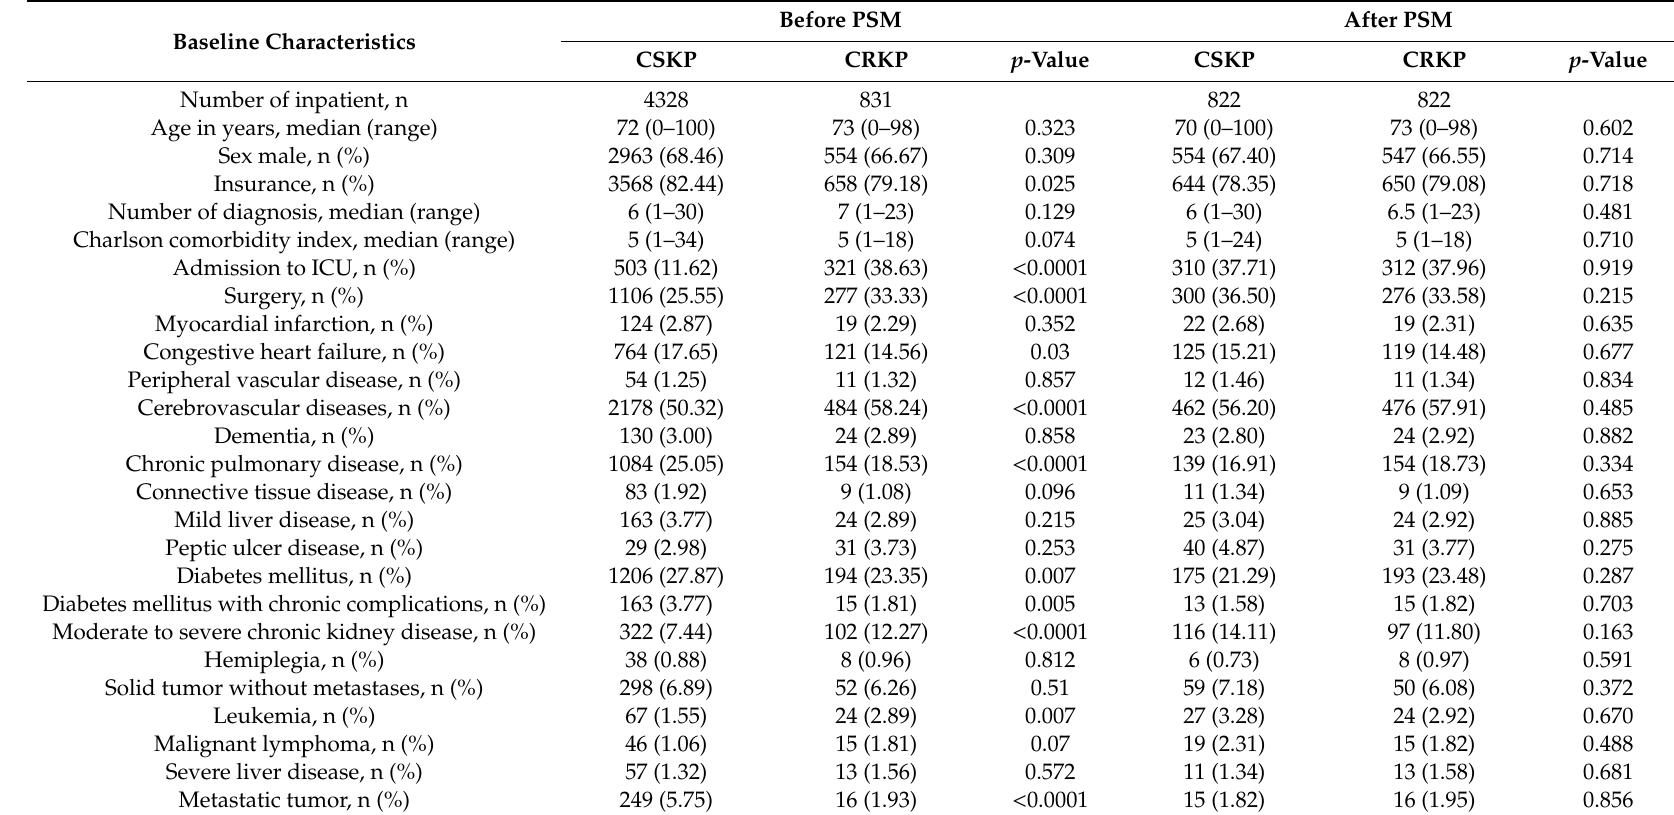
Table 1. Characteristics of the patients with CRKP and CSKP before and after